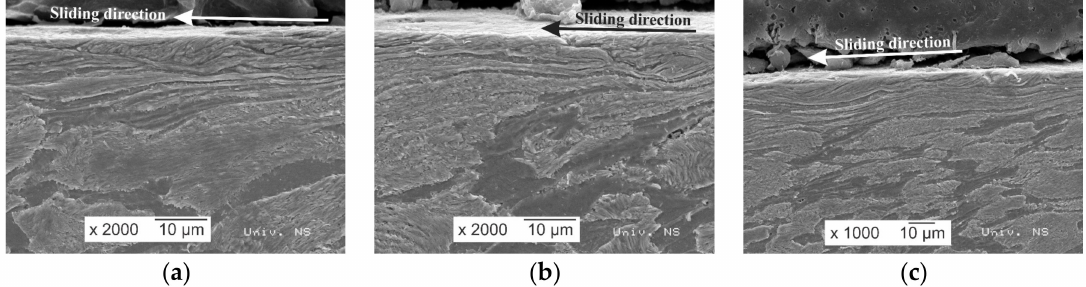
Figure 8. The thickness of the layer of severe plastic deformation after upsetting with the α = 90 deg